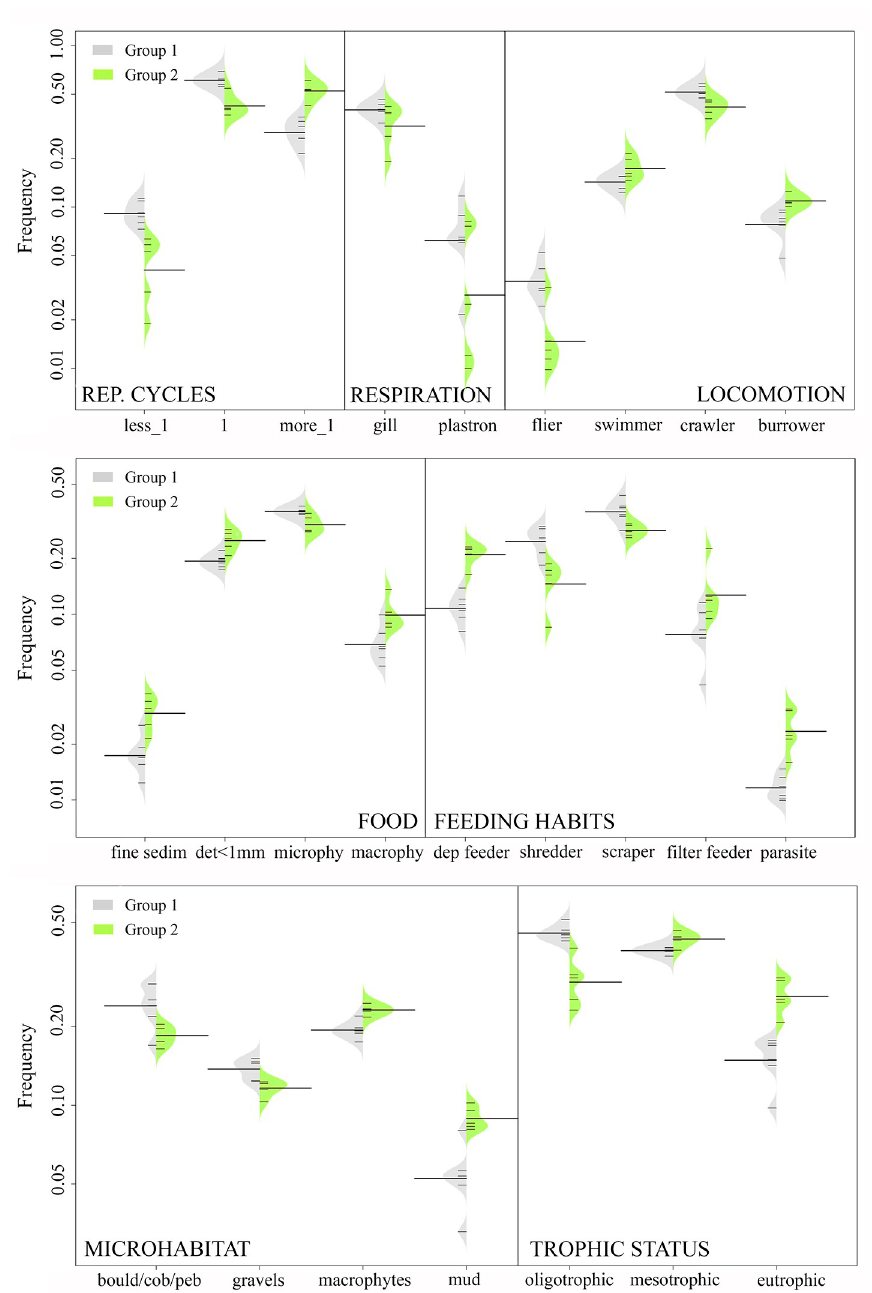
Fig 3. Functional traits analysis. Asymmetric beanplots of the functional trait categories significantly different (Mann Whitney U test, P < 0.05) between the previously established groups (Fig 2). The individual observations of each site are shown as small white lines and the average of each group is shown as a black